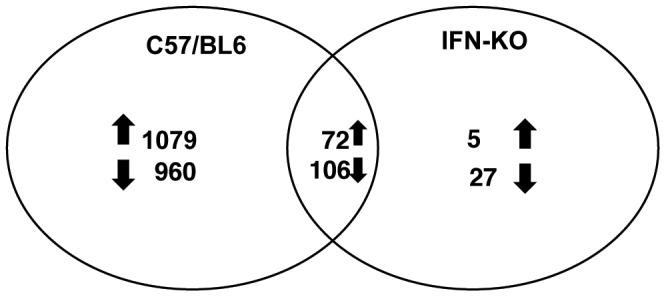
Venn diagram showing number of parasite genes with significant differences in expression in vivo in WT or IFNKO mice compared to in vitro in HFF cells.Diagram shows the number of parasite genes that were (↑) induced/(↓) repressed in wild type C57/BL6 and IFN-γ KO mice compared to in vitro in HFF cells. Genes showing ≥2 fold difference and p values <0.01 for comparisons between in vitro and in vivo (WT) and p<0.05 when comparing in vitro and in vivo (IFNKO) samples were deemed significant.